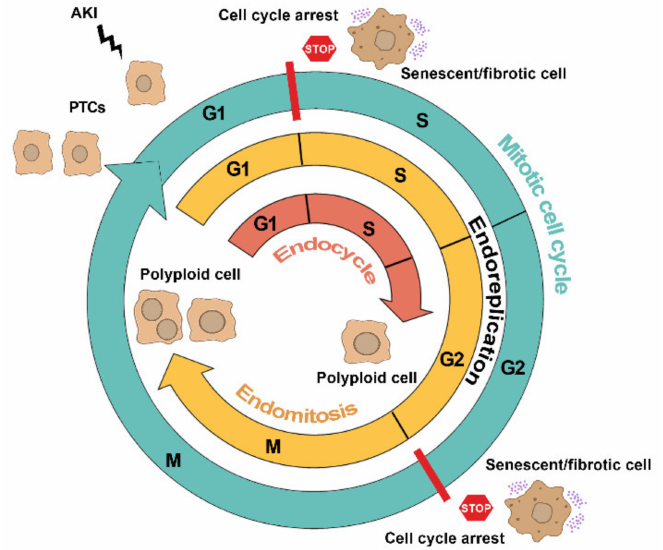
Figure 1. Distinct cell cycle programming triggered in PTC upon acute injury. The scheme depicts the different possible fates of cell cycle programming in PTC after AKI. The mitotic cell cycle (light blue line) progressing through G1, S, G2, and M phases generates two daughter cells. Cell cycle arrest (red line with stop sign) of PTC at G1 and G2 checkpoints triggers a senescent/fibrotic phenotype. Alternative cell cycle (i.e., endoreplication) generates mono/multinuclear polyploid cells via endomitosis (yellow line) or mononuclear polyploid cells via endocycle (red